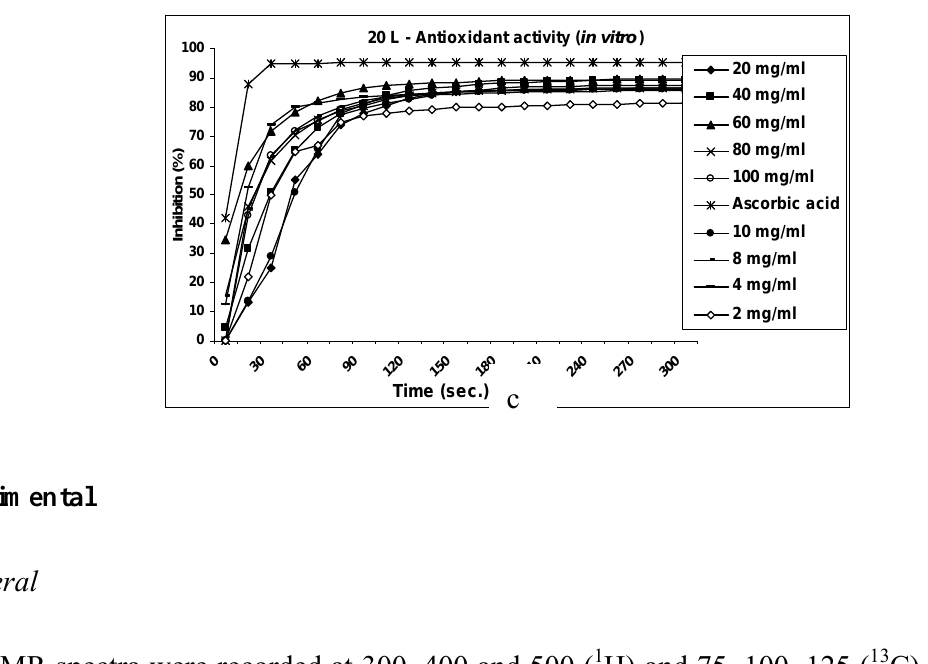
Figure 2. Cont. 20 L - Antioxidant activity ( in vitro